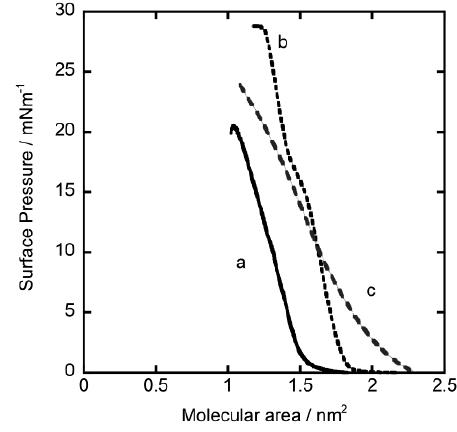
Figure 1. The π-A curves of (a) DFPPY, (b) PPY and (c) PIQ, using 10 mgL −1 of synthetic saponite as a subphase (modified from reference [67]).